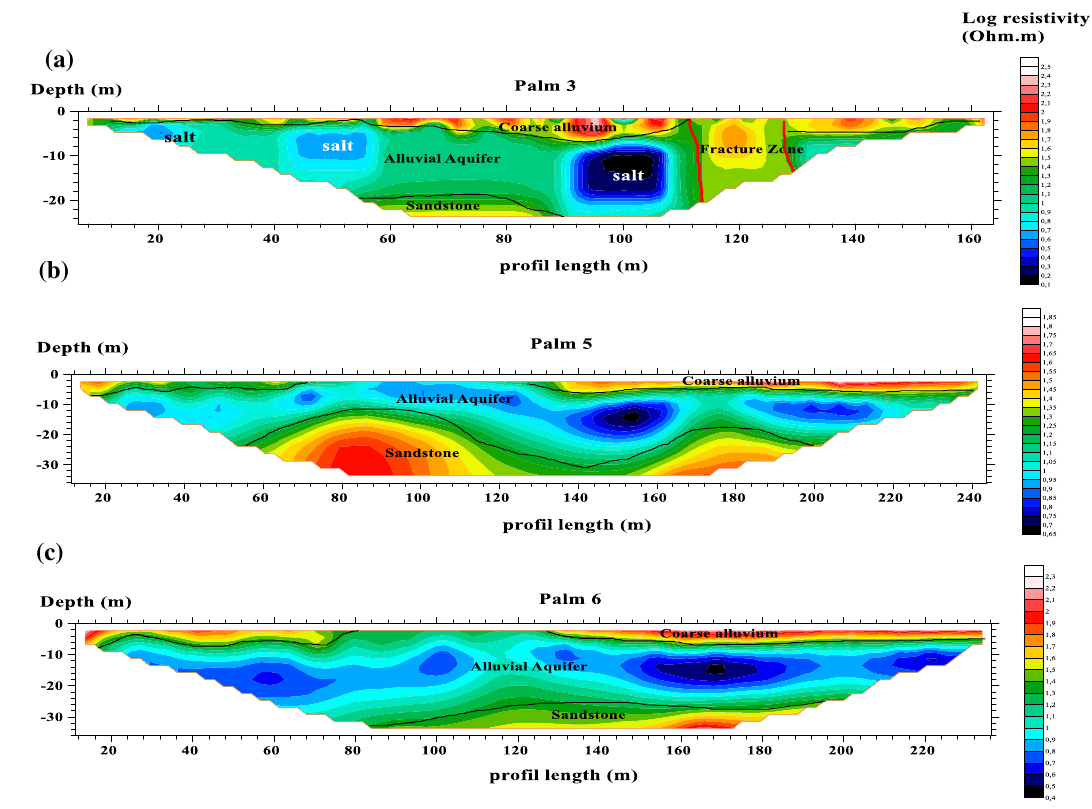
Fig. 7 2D Electric tomography for profiles palm 3, palm 5, and palm